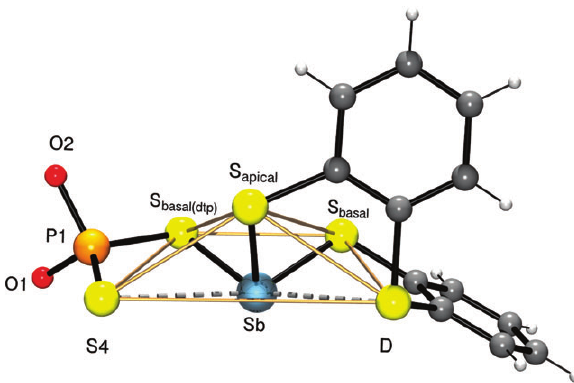
Figure 2 Polyhedral arrangement around antimony (in golden color; the R groups bonded to O,O ′ -dithiophosphate moiety have been